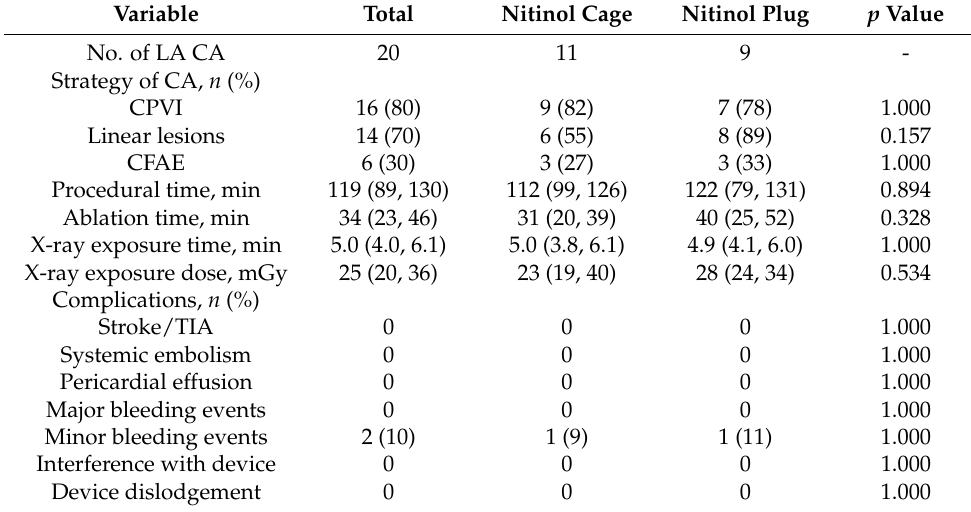
Table 2. Periprocedural data.